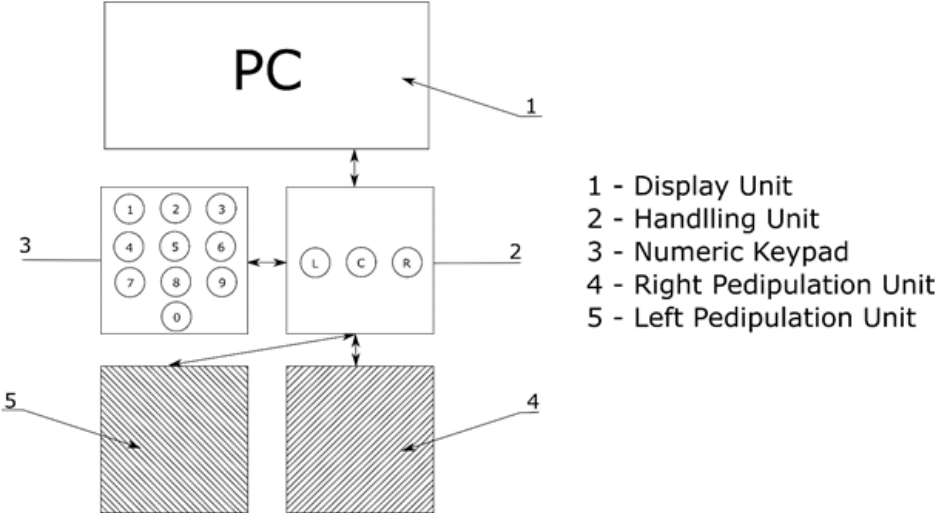
Figure 4. The technical solution of the device for measuring the reaction time and the relative error rate in multitasking tasks.